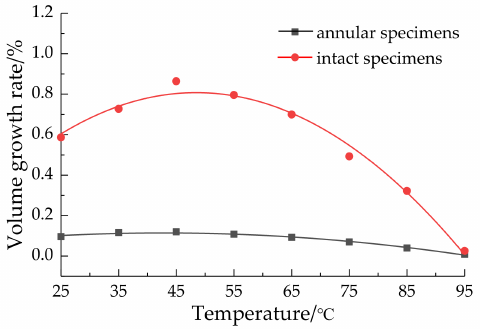
Figure 6. The volume growth rate varies with water temperature. The density growth rate presents a law under mass and volume changes, as shown in Figure 7.